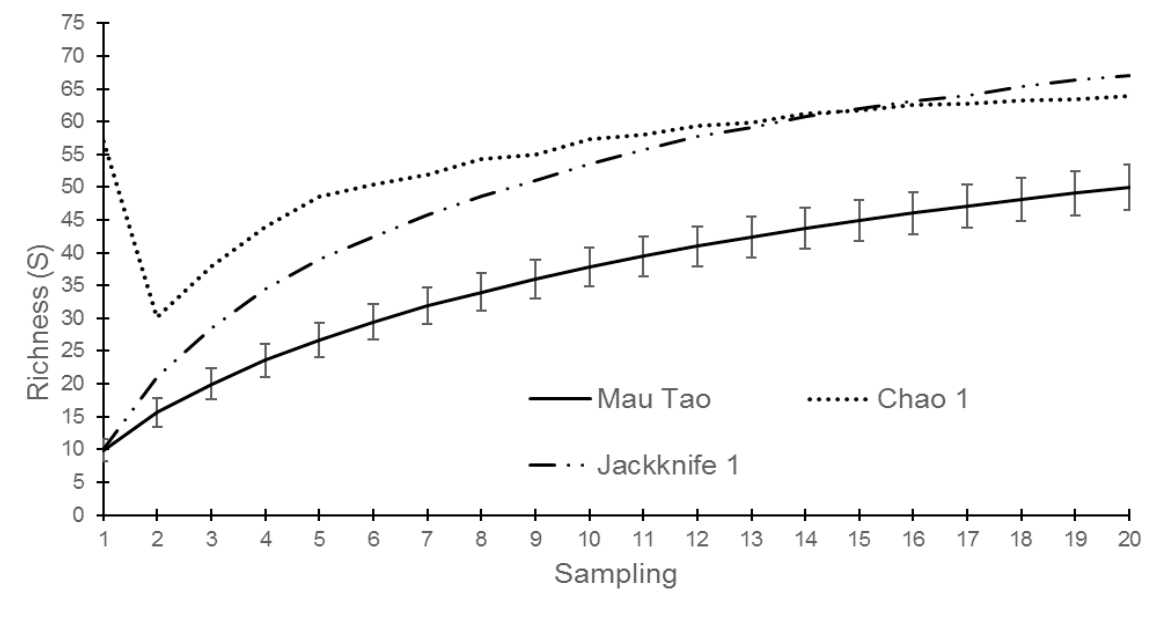
Fig 2 . Mao Tau, Chao 1 and Jackknife 1 species accumulation curve, with respective standard